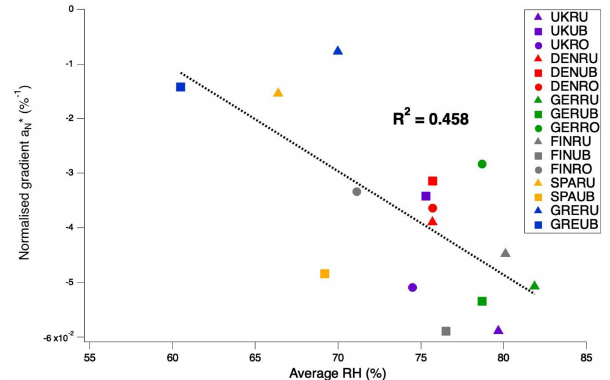
Figure 3. Normalised gradients a ∗ lated with solar irradiance).